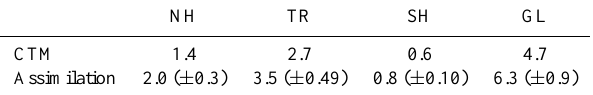
Table 2. The annual total LNO x sources (in TgNyr − 1 ) obtained from the CTM simulation and the data assimilation for the North- ern Hemisphere (NH, 20–90 ◦ N), the tropics (TR, 20 ◦ S–20 ◦ N), the Southern Hemisphere (SH, 90–20 ◦ S), and the globe (GL, 90 ◦ S–90 ◦ N). The analysis uncertainty estimated from the mean analysis spread is shown in